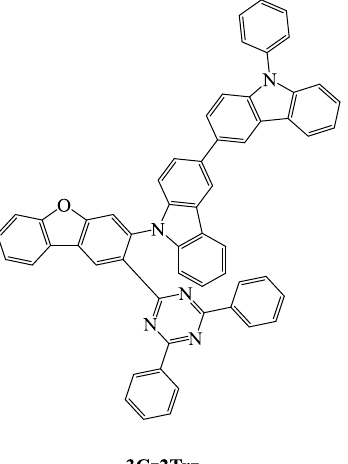
Figure 2. Molecular structures of triazine acceptors with carbazole, along with other donor derivatives.